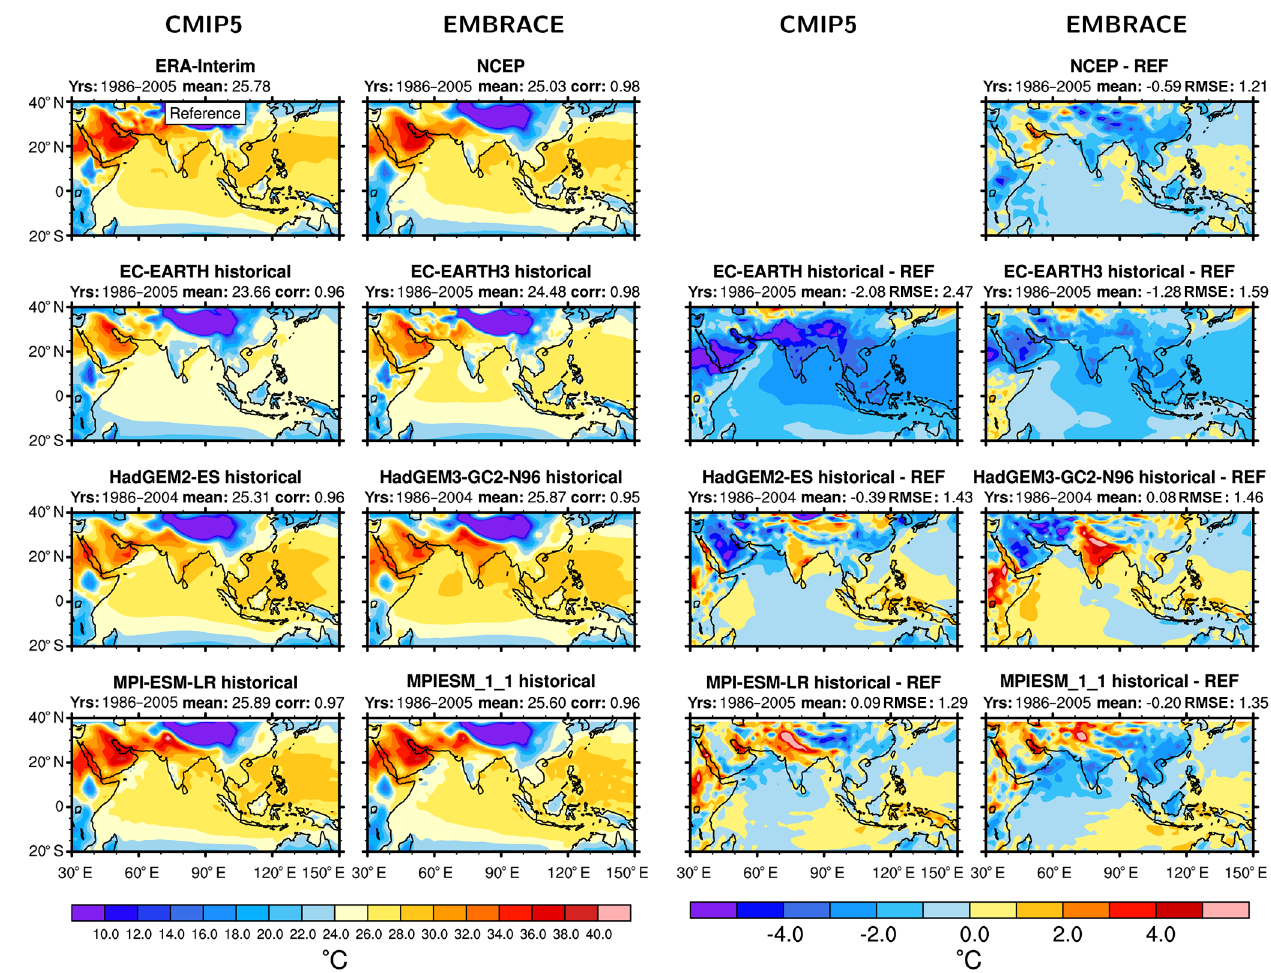
Figure 4. Leftmost two columns: seasonal mean 2m temperature for JJAS from reanalysis data (ERA-Interim), the NCEP 1 dataset, and the coupled simulations averaged over the years 1986–2005 (HadGEM: 1986–2004). Rightmost two columns: differences relative to ERA- Interim. Columns 1 and 3 show the original CMIP5 model versions, columns 2 and 4 the EMBRACE-updated models. The domain-averaged annual mean (“mean”), linear pattern correlation (“corr”; leftmost two columns), mean bias (“mean”), and root mean square error (RMSE; rightmost two columns) compared with ERA-Interim are given above the individual